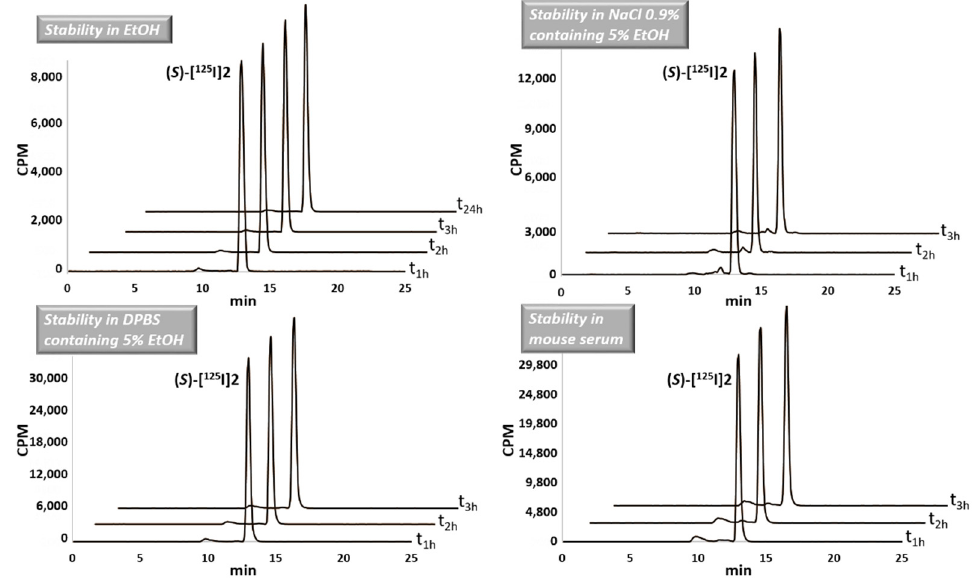
Figure 7. Radioactivity-HPLC chromatograms of the radiotracer ( S )-[ 125 I] 2 incubated, for 1, 2, and 3 h post formulation, at room temperature in ethanol, NaCl 0.9% containing 5% ethanol, and DPBS (pH 7.4) containing 5% ethanol, as well as in a mixture of DPBS and mouse serum at 37 °C. For the production of the radiofluorinated analogue ( S )-[ 18 F] 3 (Scheme 3), the same organotin precursor ( S )- 15 was treated with [ 18 F]LiF and tetrakis(pyridine)copper(II) triflate (Cu(OTf) 2 (py) 4 ) in N , N -dimethylacetamide (DMA) according to a protocol routinely used in our laboratory for the copper-mediated radiofluorination of nonactivated aromatic derivatives in the presence of oxygen and with small amounts of base [33]. In all reaction conditions tested (variation of temperature, equivalents of Cu(OTf) 2 (py) 4 , molar quantity of precursor, duration of heating, etc.), moderate RCC was achieved (18.6 ± 2.5%, n = 7, Figure 5B). In parallel to the formation of ( S )-[ 18 F] 3 , no radioactive by-products except remaining [ 18 F]F − could be identified by radio-TLC monitoring or by analytical HPLC. Interestingly, a fast change in the colour of the reaction mixture (blue to dark brown/black) was noticed immediately after addition of the organotin precursor to the mixture [ 18 F]LiF/Cu(OTf) 2 (py) 4 , even before any heating process. As efficiency of copper-mediated radiofluorinations can be affected by various parameters, such as the presence of chelating agents, a detrimental interaction of the N - heterocyclic precursor with the copper complex was suspected. In order to confirm this assumption, comparative assays were performed based on the work of Chen and coworkers [34]. A model radiofluorination reaction, namely the production of 7- [ 18 F]fluorotryptophan (7-[ 18 F]FTrP) starting from the corresponding aryl boronate precursor, was chosen [35]. With the optimised reaction conditions typically used in our laboratory, reproducible high RCC (88.1 ± 3.2%, n = 5, data not shown) was achieved for the production of 7-[ 18 F]FTrP via copper-mediated radiofluorination. When adding an equimolar amount of the organotin precursor ( S )- 15 in the reaction mixture of the radiofluorination of 7-[ 18 F]FTrP, the labelling efficiency dramatically decreased to 19%, indicating that precursor ( S )- 15 appeared to act as a poison of the copper complex. Nevertheless, ( S )-[ 18 F] 3 could be produced in sufficient amounts to perform subsequent purification steps. First, the crude radiofluorination mixture was purified by C18 SPE cartridge. The acetonitrile eluate obtained was then applied on a semipreparative HPLC system, and the collected fraction corresponding to ( S )-[ 18 F] 3 was passed through a second C18 SPE cartridge to remove HPLC solvents. Finally, elution with a small volume of ethanol and formulation provided the radiotracer ( S )-[ 18 F] 3 in a sterile saline solution